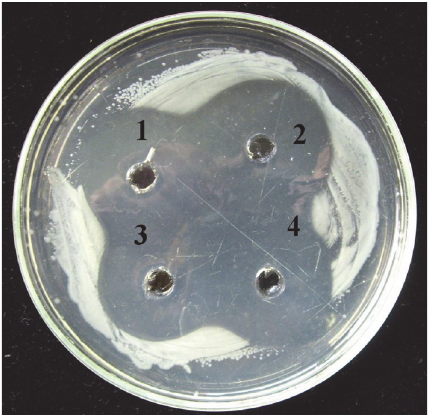
Figure 1: Agar diffusion test for determination of antibacterial activity towards E. carotovora in extracts of K. pinnata transgenic lines. (1) K. pinnata , line #1, halo 29 mm; (2) synthetic CecP1 (1 𝜇 g/mL), halo 34mm; (3) K. pinnata , line #2, halo 26mm; (4) K. pinnata line #3, halo 28 mm.